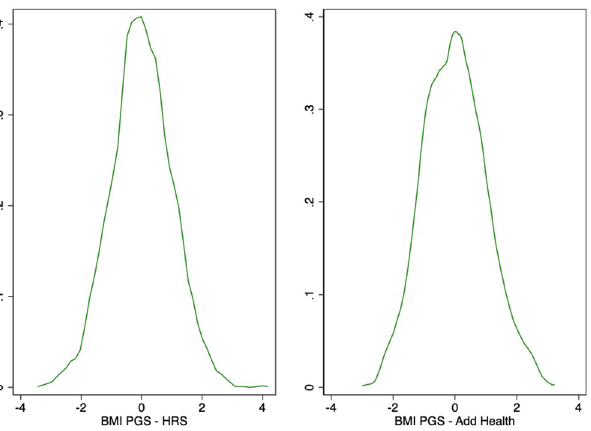
Fig 1. BMI polygenic scores (Normalized) in the HRS original cohort and in add health. Kernel Density Estimates . This figure displays the kernel-smoothed densities of HRS and Add Health respondents’ BMI polygenic scores in the balanced samples described in Tables 1 and 2, respectively. Number of observations: 3,181 (HRS Original cohort) and 2,730 (Add